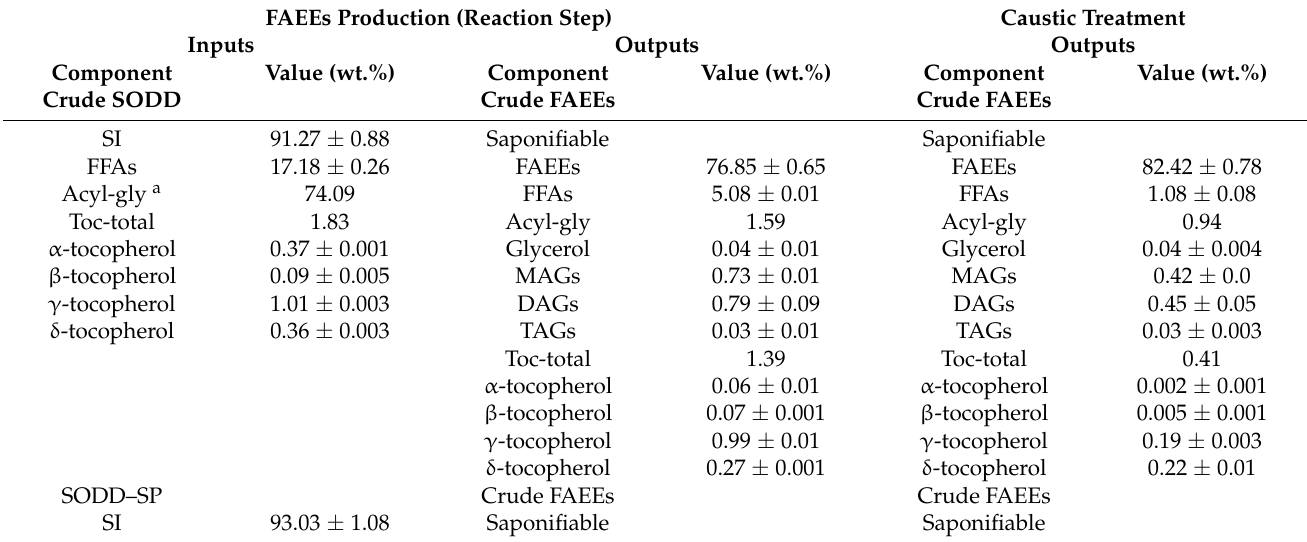
Table 3. Mass percentage of main components of producing FAEEs from low-to-high acidity SODD. FAEEs Production (Reaction Step) Caustic